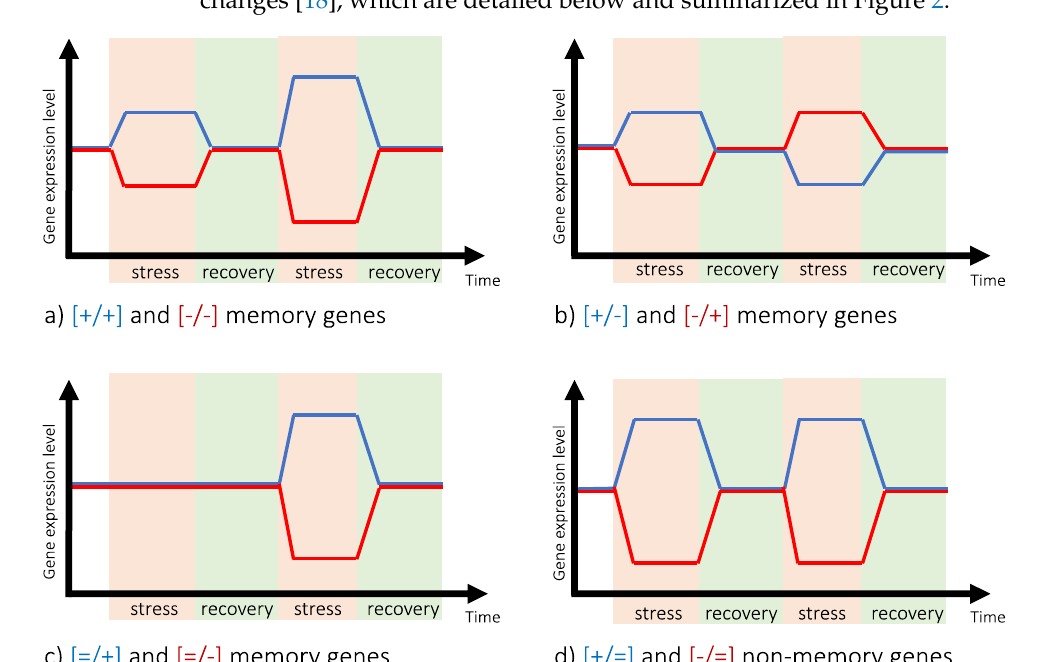
Figure 1. Different transcriptional patterns occurring in response to repeated stress treatments. Gene expression level is expressed relative to that of nonstressed plants. Memory genes have altered transcriptional responses to a subsequent stress. ( a ) Memory genes with [+/+] or [ − / − ] expression patterns; ( b ) Memory genes with [+/ − ] or [ − /+] expression patterns; ( c ) Memory genes with [=/+] or [=/ − ] expression patterns ( d ) Non-memory genes responding similarly to each stress. Adapted from Ding et al. [26].